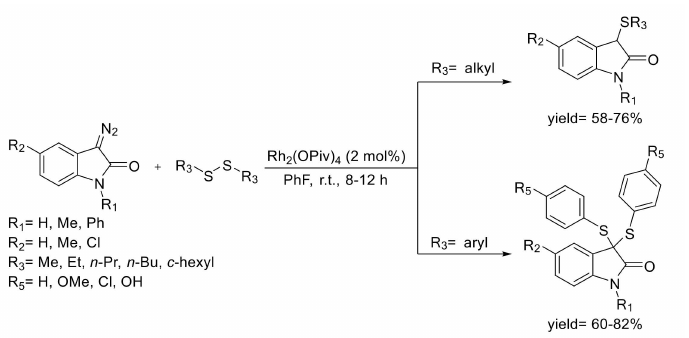
Scheme 1. C-S coupling reaction of diazo compounds and